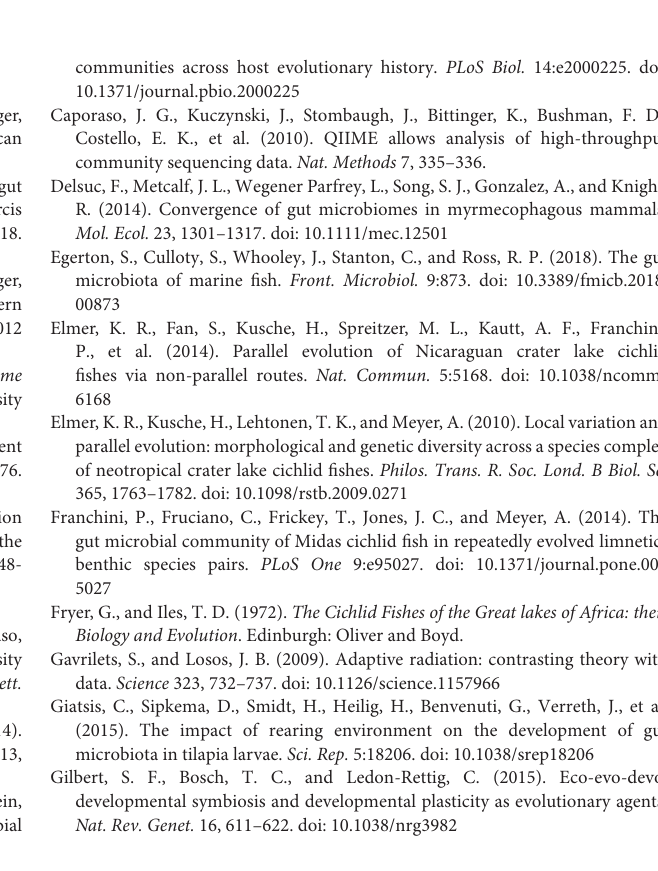
TABLE S5 | Discriminatory taxa and OTUs between continents and across lakes. TABLE S6 | PERMANOVA